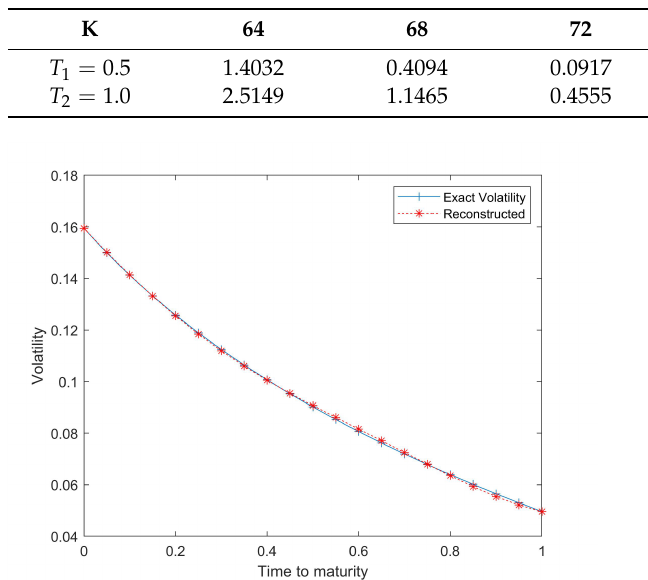
Table 1. The exact option prices for Example 1.